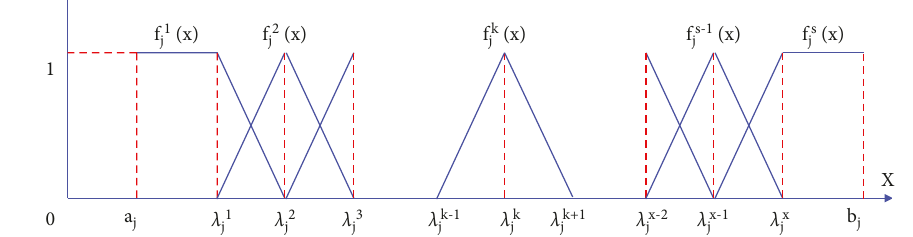
Figure 8: Schematic diagram of center point hybrid type.